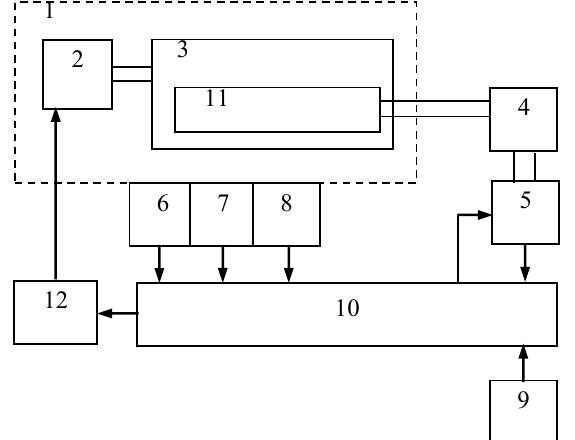
Figure 1. Structural diagram of a typical